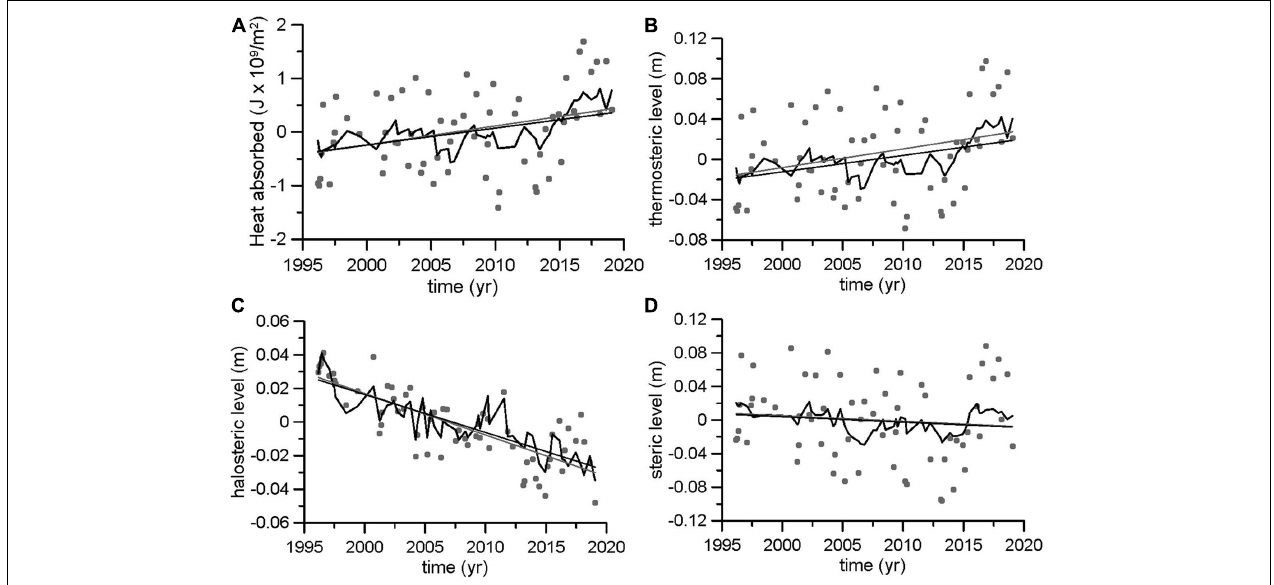
FIGURE 9 | Heat absorbed (in Joules × 10 9 /m 2 , A ), thermosteric (B) , halosteric (C), and steric (D) sea level (in m) in the Balearic Channels. For each campaign, the heat absorbed and the steric, thermosteric, and halosteric sea level are estimated as variations from the mean temperature and salinity profile averaged for the complete period. Gray dots correspond to the calculations from the sea surface to 1200 dbar, whereas the black lines correspond to the calculations excluding the upper 100 dbar.